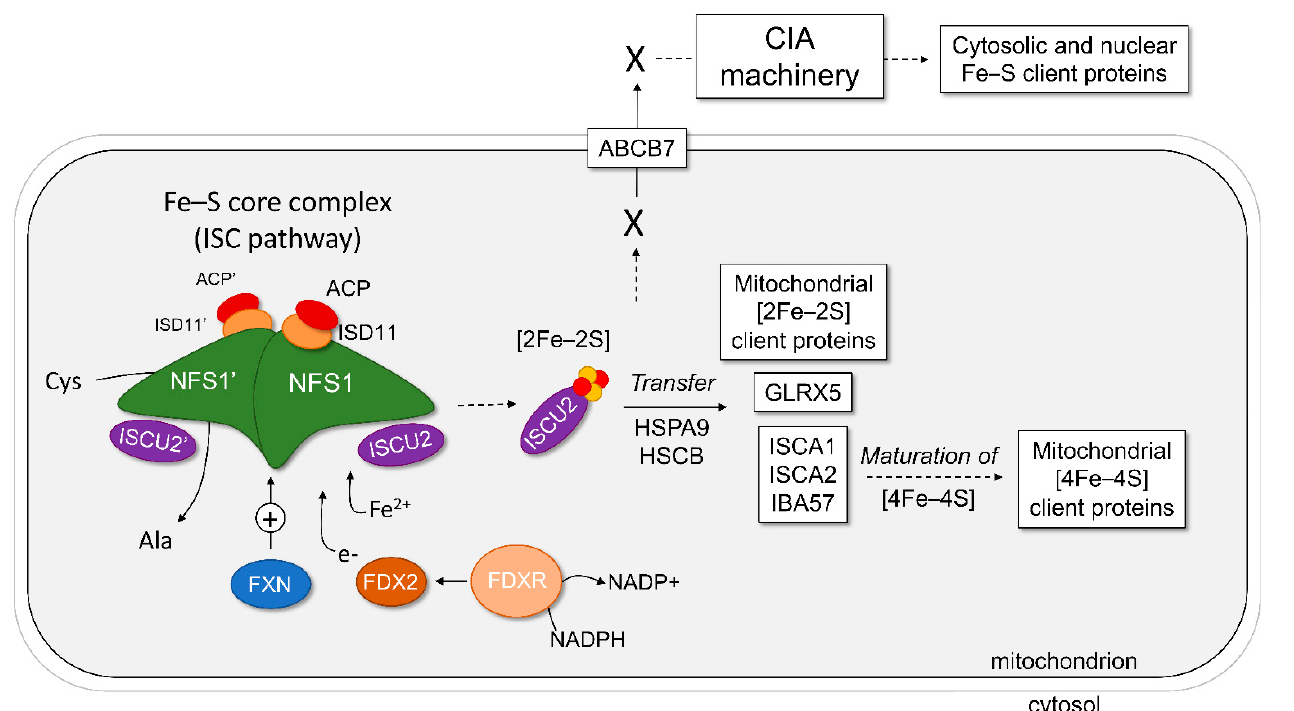
Figure 1. Representation of the human mitochondrial and cytosolic iron–sulfur cluster biosynthesis. The proteins of the Fe–S core complex are shown as drawn molecules, whereas the proteins of downstream pathways are listed in boxes. The first step of Fe–S biosynthesis involves the Fe–S core complex of the ISC pathway, which is built around the NFS1 dimer with two subunits of ISD11, ACP, and ISCU2. Frataxin (FXN) can bind the complex and stimulate (+) the formation of Fe–S on ISCU2, while electrons are donated via the ferredoxin 2 (FDX2)–ferredoxin reductase (FDXR)–NADPH pathway. This generates a [2Fe–2S] cluster bound to ISCU2. The second step is the transfer of Fe–S from ISCU2, with the help of chaperone proteins HSPA9 and HSCB, to mitochondrial client proteins as listed. The third step is the maturation of [2Fe–2S] to [4Fe–4S] clusters in the mitochondria and subsequent delivery to mitochondrial client proteins. The fourth step is the export of an unknown precursor molecule (X) generated by the ISC pathway to the cytoplasm via ABCB7 and other components of the ISC export. Finally, this precursor molecule is processed by the CIA pathway to mature and deliver Fe–S to client proteins in nearly every other cellular compartment.